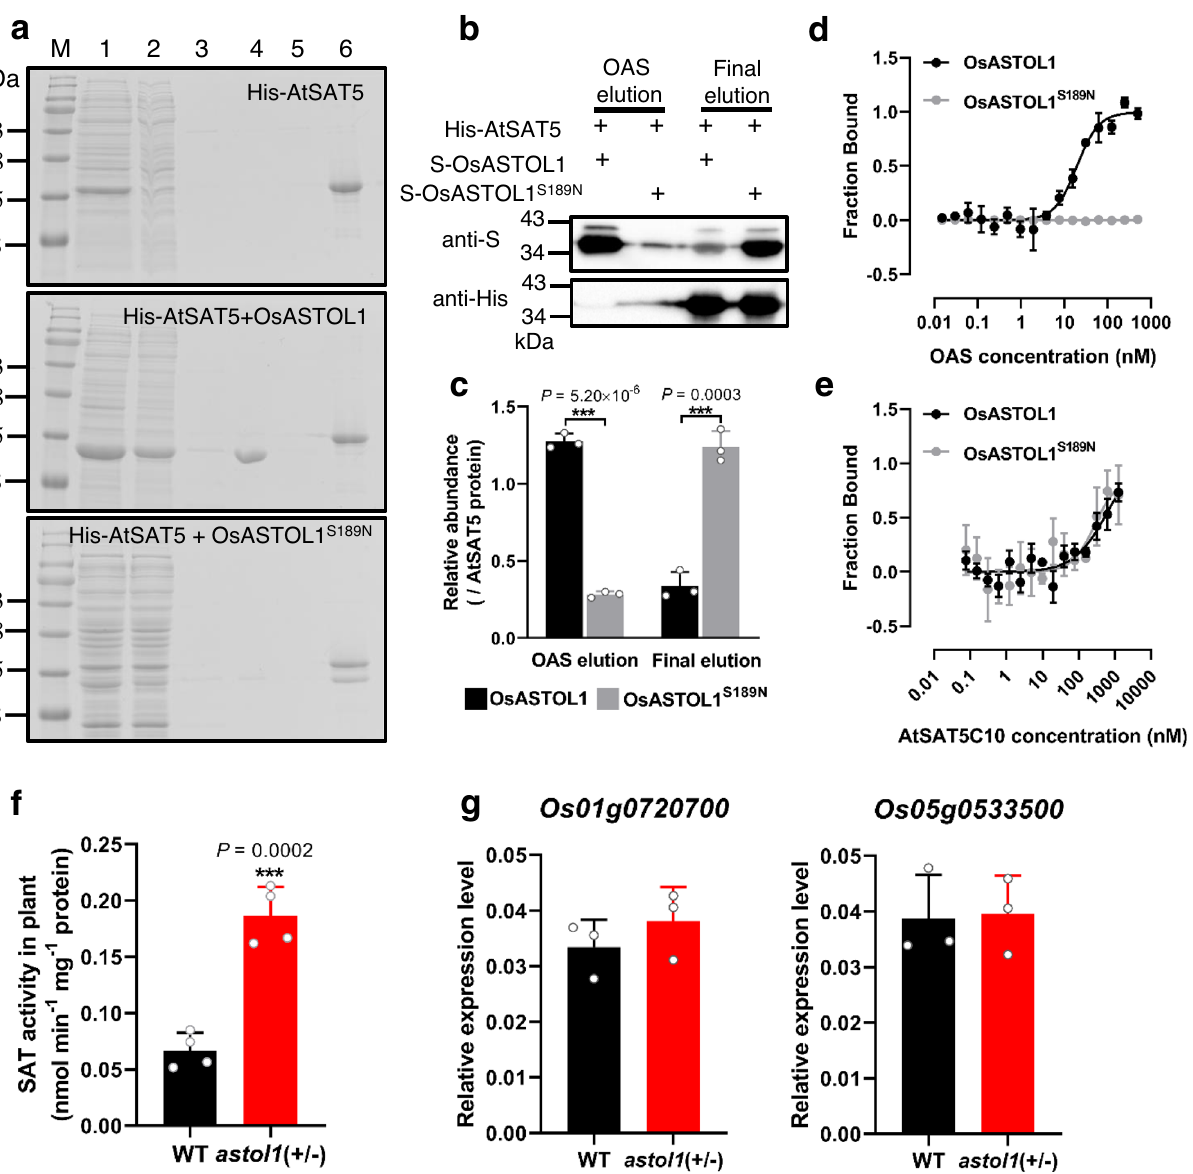
Fig. 3 astol1 mutant increases SAT activity by stabilizing cysteine synthase complex (CSC). a In vitro pull-down analysis of the dissociation effect of OAS on CSC. The fraction of different elution steps (lanes 1 – 6) from His-AtSAT5 protein (upper panel), His-AtSAT5 and mature OsASTOL1 protein (middle panel), and His-AtSAT5 and mature OsASTOL1 S189N protein (bottom panel) was analyzed by SDS-PAGE and visualized by Coomassie Brilliant Blue staining. M marker; lane 1: crude extract of His-AtSAT5 (upper), OsASTOL1 (middle) and OsASTOL1 S189N (bottom); lane 2: fl ow through of His- AtSAT5 (upper), OsASTOL1 (middle) and OsASTOL1 S189N (bottom); lane 3: washing buffer (80 mM imidazol); lane 4: OAS elution (10 mM OAS + 80 mM imidazol); lane 5: washing buffer (80 mM imidazol); lane 6: fi nal elution (400 mM imidazol). The experiment was repeated three times and similar results were obtained. b The fraction of OAS elution and fi nal elution was analyzed by SDS-PAGE and visualized by immunoblot, and a representative result of three repeated tests is shown. c The relative abundance of OsASTOL1 or OsASTOL1 S189N in the OAS elution and the fi nal elution was quanti fi ed by ImageJ software, compared to the corresponding AtSAT5 protein. Microscale thermophoresis (MST) analysis of in vitro binding of OsASTOL1 and OsASTOL1 S189N protein with OAS ( d ) or AtSAT5C10 peptide ( e ). f Total SAT enzyme activity in whole soluble protein extracts of the shoots of 3-week-old WT and astol1 ( + / − ). g Relative expression levels of two rice SAT genes ( Os01g0720700 and Os05g0533500 ) in the shoots of 3-week-old WT and astol1 ( + / − ), with OsHistone H3 as the internal reference. WT, wild type. astol1 ( + / − ), astol1 heterozygote. Data in c – e are shown as mean ± s.d., n = 3 technical replicates. Data in f – g are shown as means ± s.d., n = 4 ( f ) or 3 ( g ) biological replicates; each biological replicate represents an individual plant. Asterisks in c , f , g indicate signi fi cant difference by two-sided Student ’ s t test: ** P < 0.01, *** P <